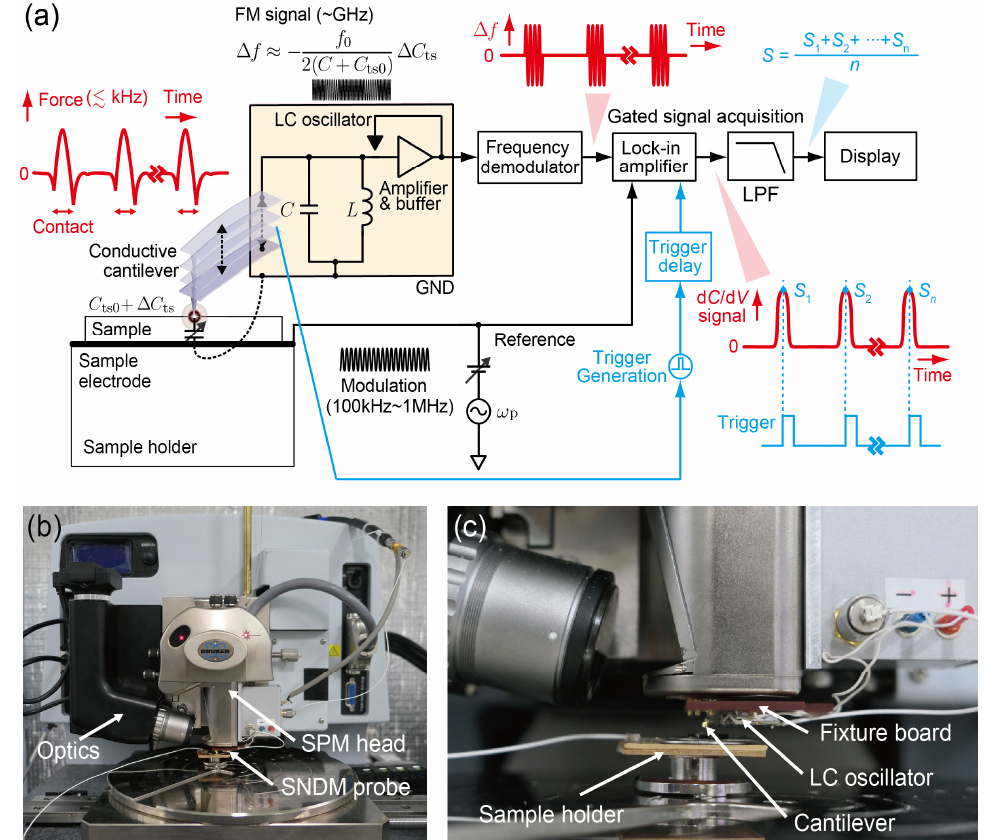
Figure 6. ( a ) Schematic diagram of BA-PFT-SNDM. Gated signal acquisition is realized by triggered signal sampling at the lock-in amplifier. The generated trigger pulse train is synchronized with periodic cantilever motion and appropriately delayed to obtain the highest signal intensity. The signal is further averaged by offline software averaging. ( b ) Overview photograph of the SPM system (Bruker Dimension Icon) with a SNDM probe. ( c ) Close-up picture of the SNDM probe attached to the SPM head.